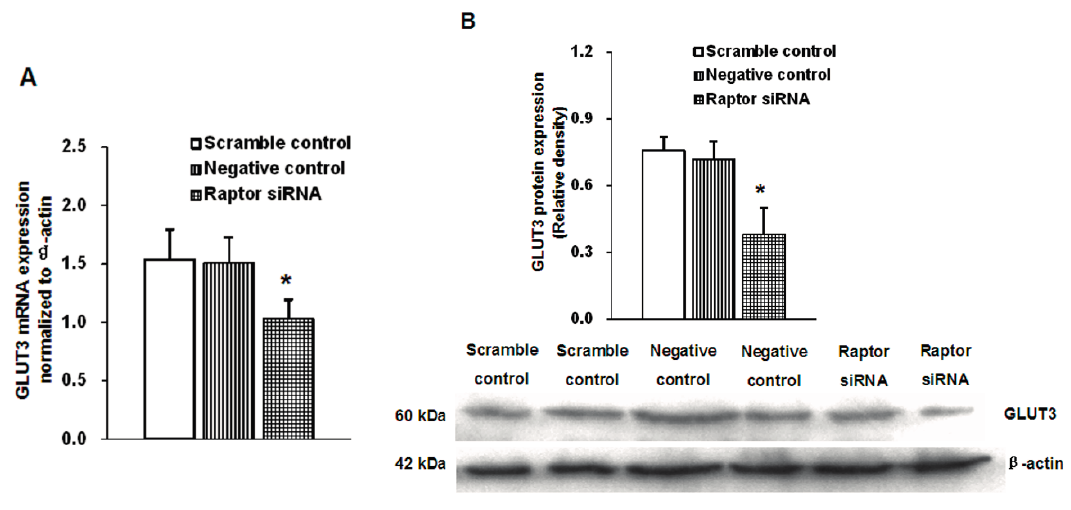
Figure 5. Effect of raptor silencing on the expression of trophoblast GLUT3. ( A ) Effect of raptor silencing on the expression of GLUT3 mRNA. The mRNA expression of GLUT3 was decreased by 41% in raptor siRNA cells, Values are mean ± SD. n = 5, * p < 0.05 vs. negative control and scramble control by Mann-Whitney U -test; ( B ) Effect of raptor silencing on the GLUT3 protein expression. The expression of GLUT3 protein was decreased by 50% in raptor-silenced cells, Values are mean ± SD. n = 4, * p < 0.05 vs. negative control and scramble control by Mann-Whitney U -test.